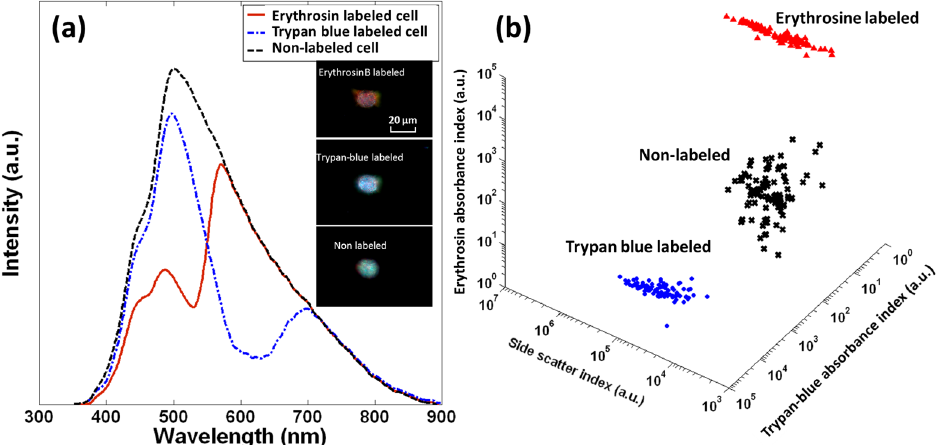
Figure 7. ( a ) Wavelength spectra of stained and non-stained gastric epithelial (AGS) cells. Note that the insets show the captured dark-field images of stained and non-stained AGS cells, respectively; ( b ) 3D scatter plot of the side-scatter index and the absorbance indices of stained AGS cells, respectively.